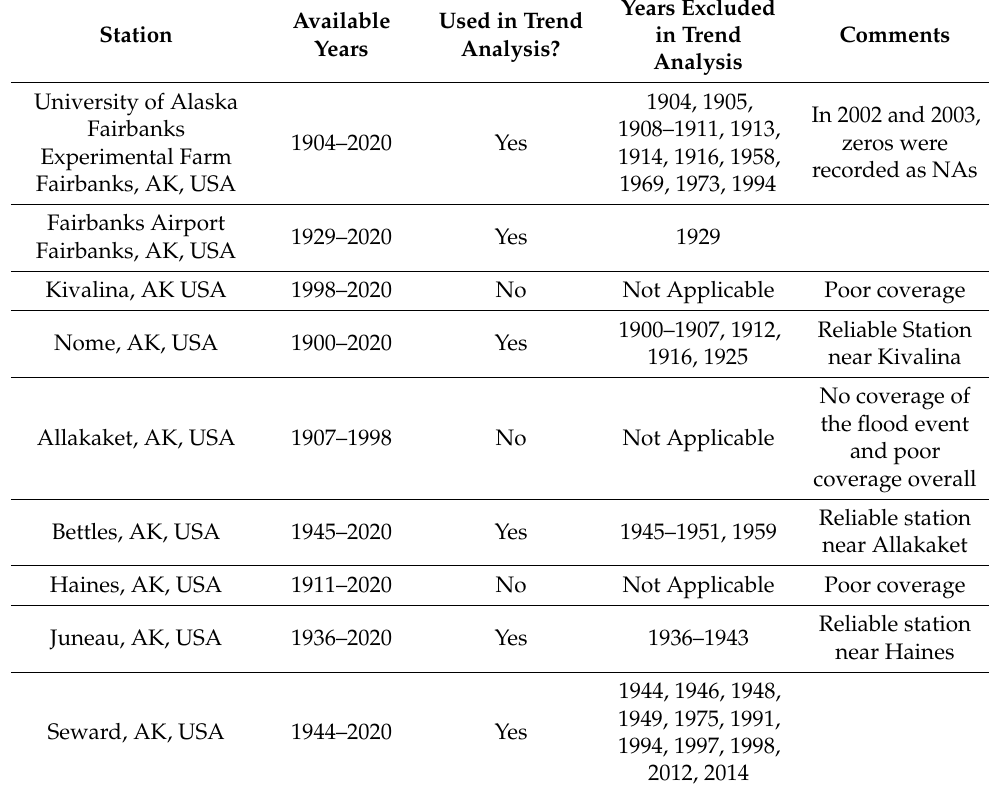
Table 1). We defined “substantial missing data” as missing more than three data points (days) in a single month. Table 1. Station data